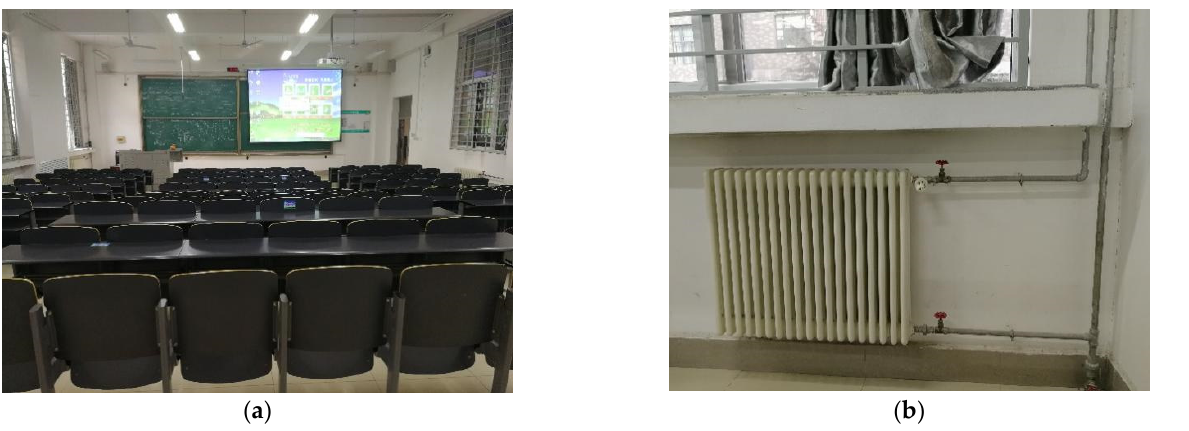
Figure 2. The studied classroom: ( a ) interior view of the classroom, ( b ) heating radiator.